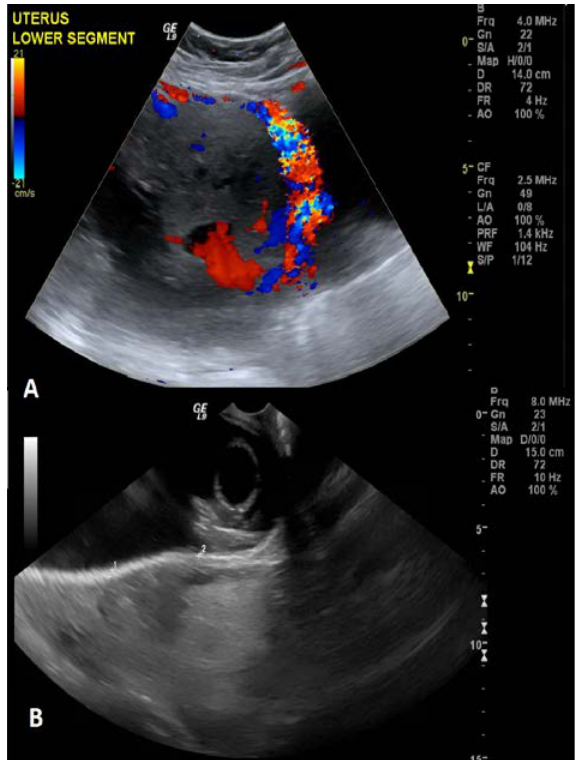
Figure 1 . Clinical images: A. Doppler Ultrasound and